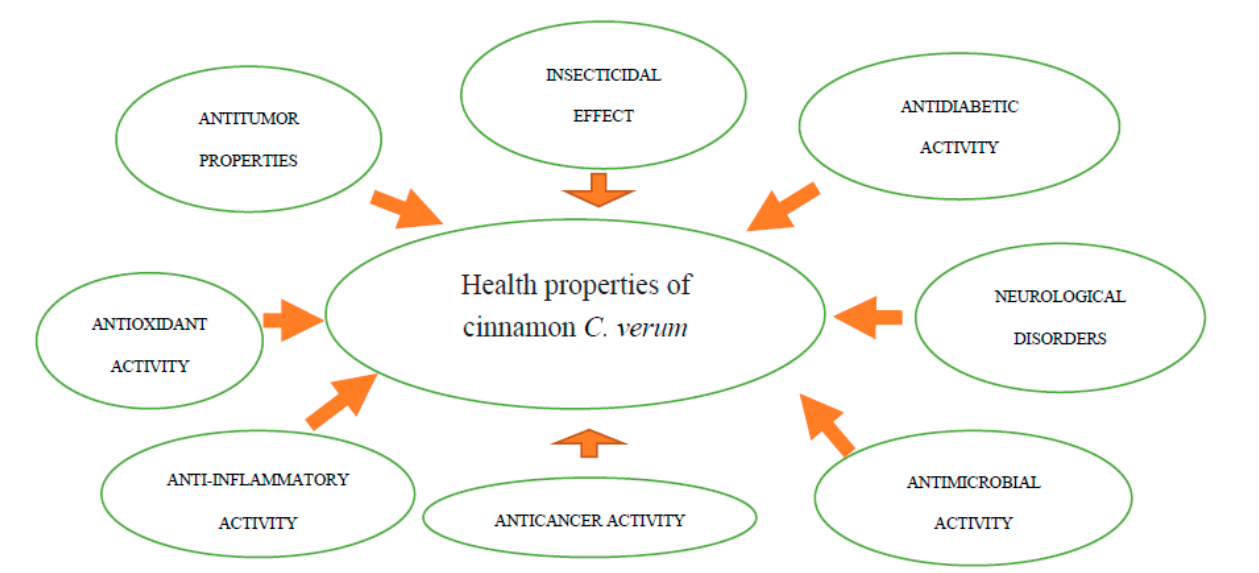
Figure 4. Health properties of cinnamon C. verum. Source: own study. Table 4. Health properties of cinnamon based on other authors’ studies.